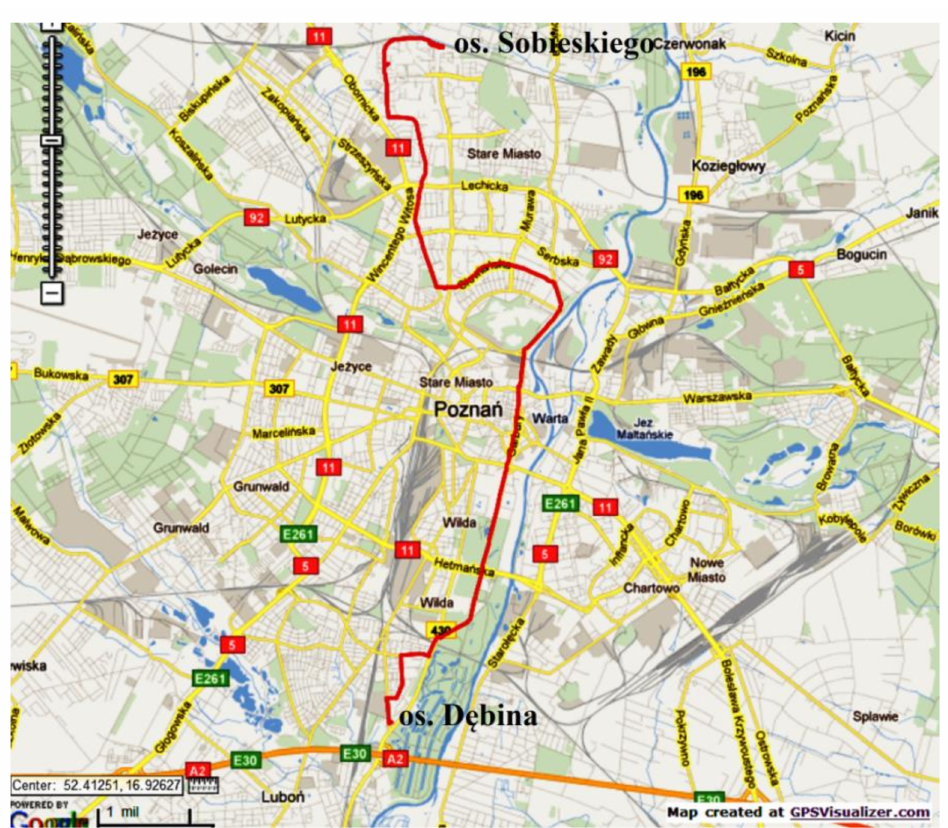
Figure 2. The course of the bus route number 76 in the city of Pozna´n on which the emissions of hybrid bus were tested.